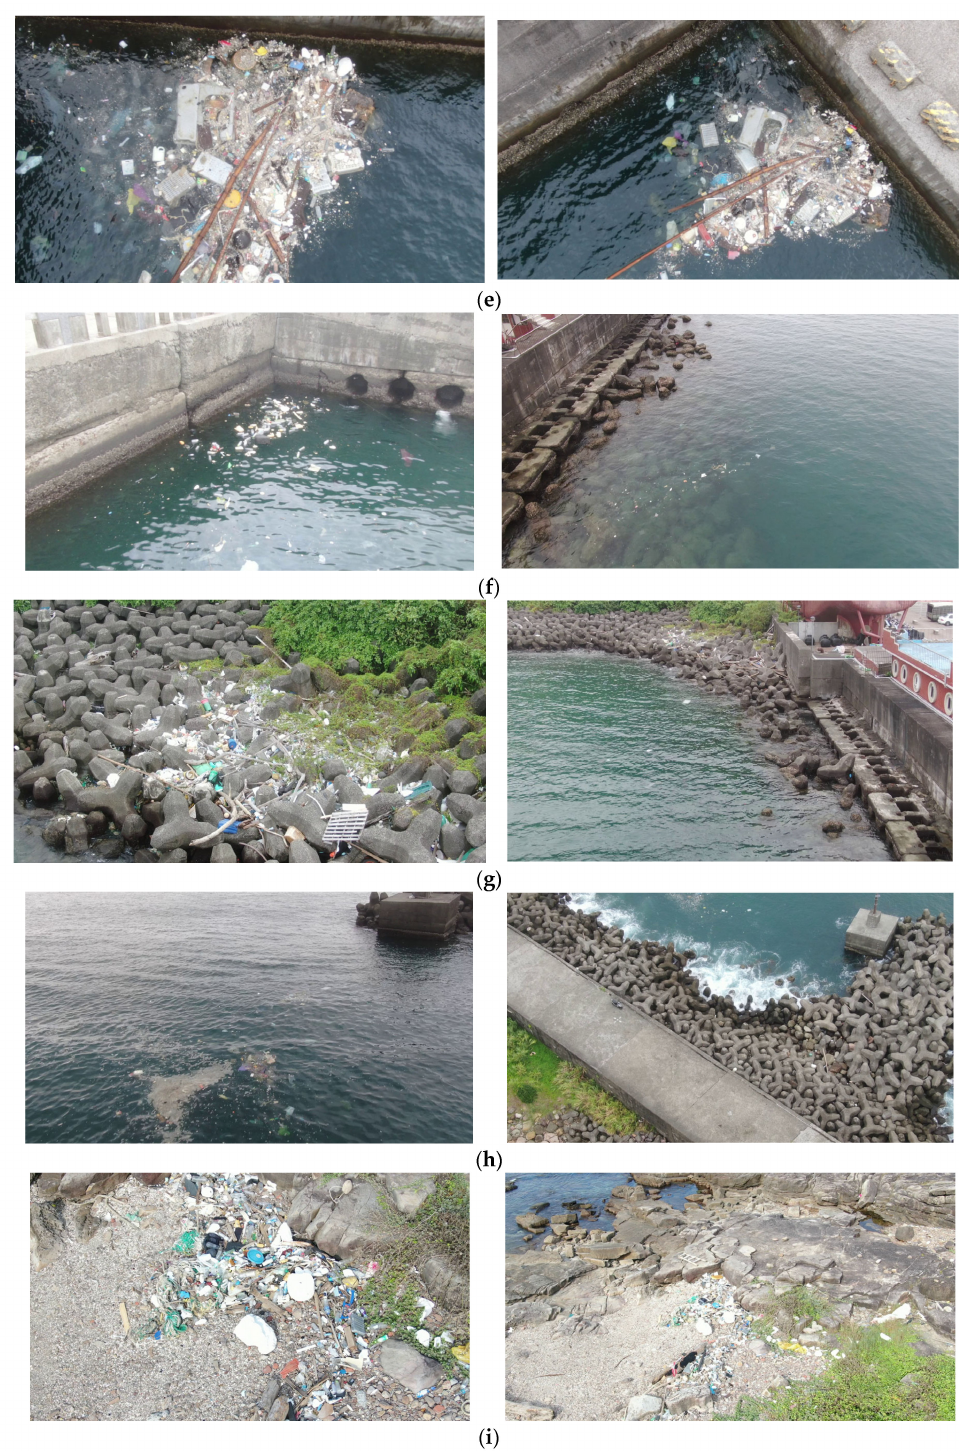
Figure 2. Garbage and bottles in the HAIDA trash dataset. ( a ) Bottles on the campus of the NTOU at heights of 3 and 10 m. ( b ) Bottles on the coastline of the NTOU at heights of 3 and 5 m. ( c ) Garbage and bottles in the Badouzi fishing port at heights of 4 and 10 m. ( d ) Garbage and bottles in the Badouzi fishing port at heights of 20 and 30 m. ( e ) Garbage in the Badouzi fishing port at heights of 3 and 7 m. ( f ) Garbage in the Badouzi fishing port at heights of 3 and 12 m. ( g ) Garbage and bottles in the Badouzi fishing port at heights of 7 and 15 m. ( h ) Garbage and bottles in the Badouzi fishing port at heights of 10 and 30 m. ( i ) Garbage in the Gongliao beach at heights of 6 and 15